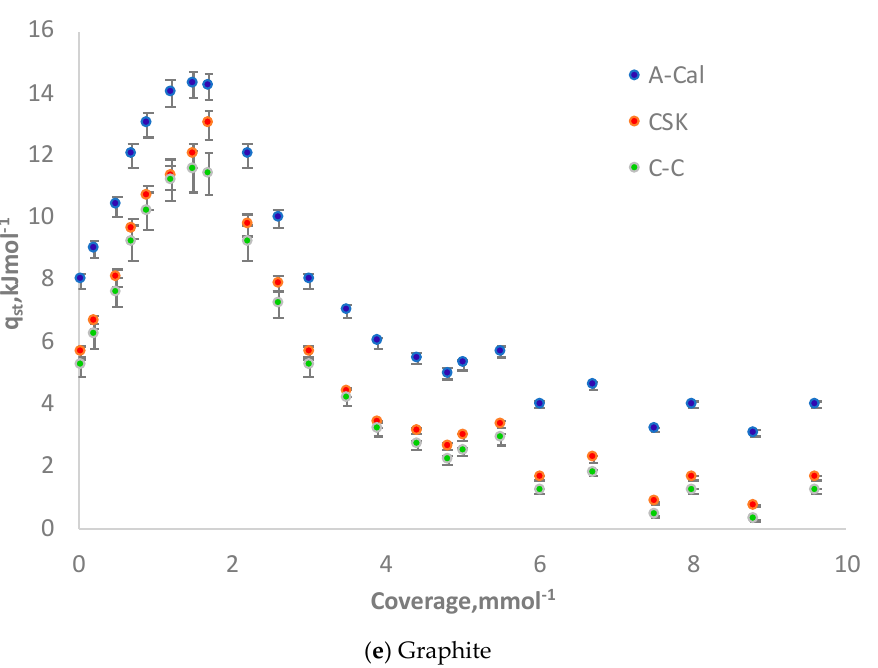
Figure 7. Isosteric heats of adsorption for N 2 . ( a ) MOF-199; ( b ) MCM-41; ( c ) SBA-15; ( d ) GACKP; ( e ) Graphite.